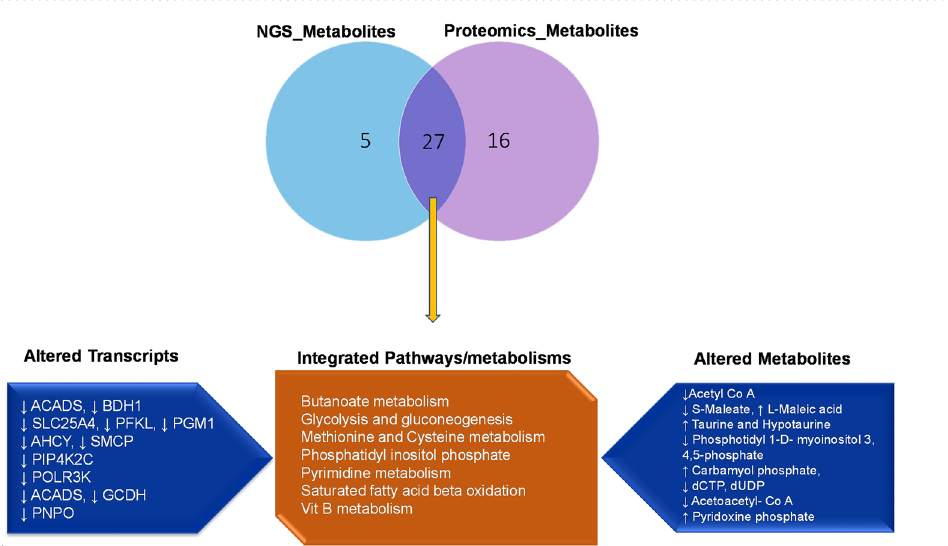
Figure 8. Venn diagram of common dysregulated pathways of translated proteins and